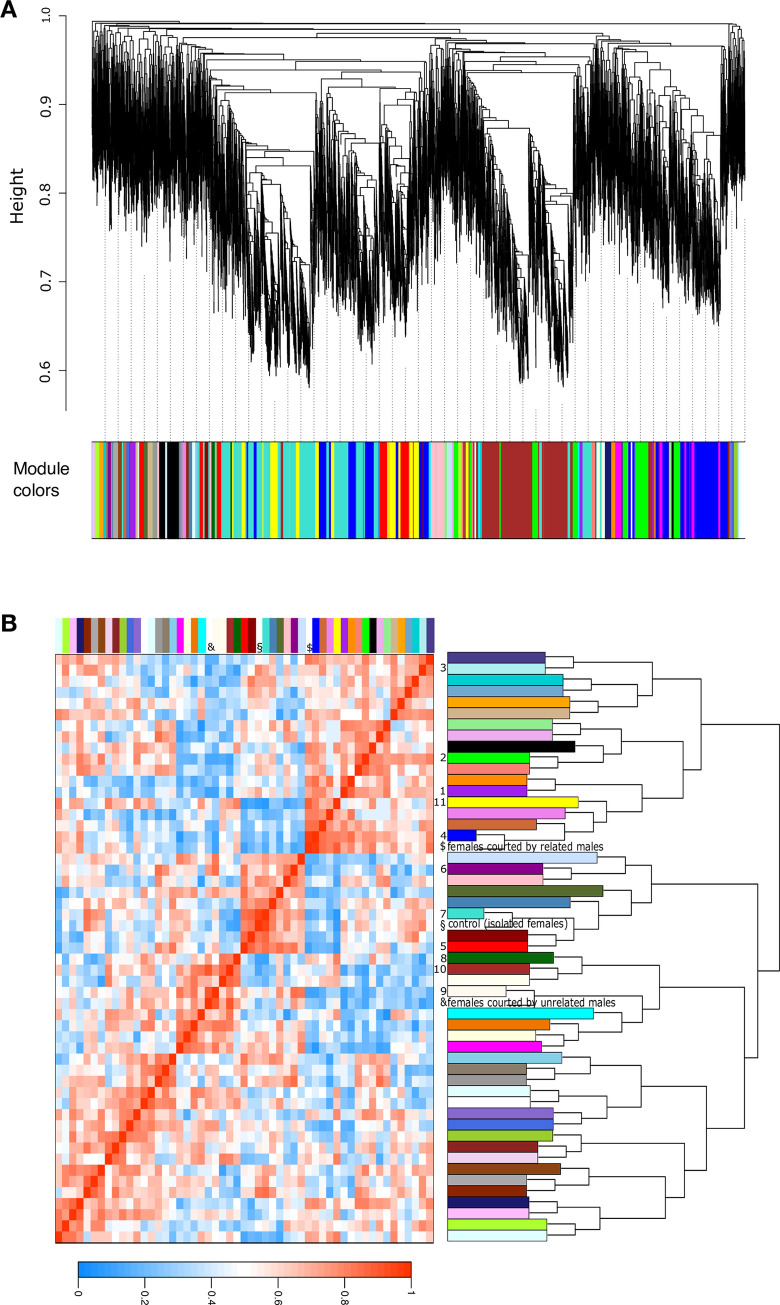
Gene co-expression network of the full transcriptome (14,027 genes) in response to courtship and according to relatedness with the courting male.(A) Clustering dendrogram of 14,027 genes (top side), with assignation to 50 modules of co-expressed genes represented by colors (bottom side). B) Summary plot of modules dendrogram and relationship with social environment experienced. The right panel shows the dendrogram of modules from gene network. The heatmap (left panel) illustrates pairwise correlation between modules of co-expressed genes and social environment: red denotes high positive correlation, white indicates no correlation, while blue indicates high negative correlation. The 11 modules significantly correlated with at least one of the social environment experimented by females were numbered from 1 to 11. Social environments were labelled with symbols: §; control (isolated females), $; females courted by related males, and &; females courted by unrelated males.